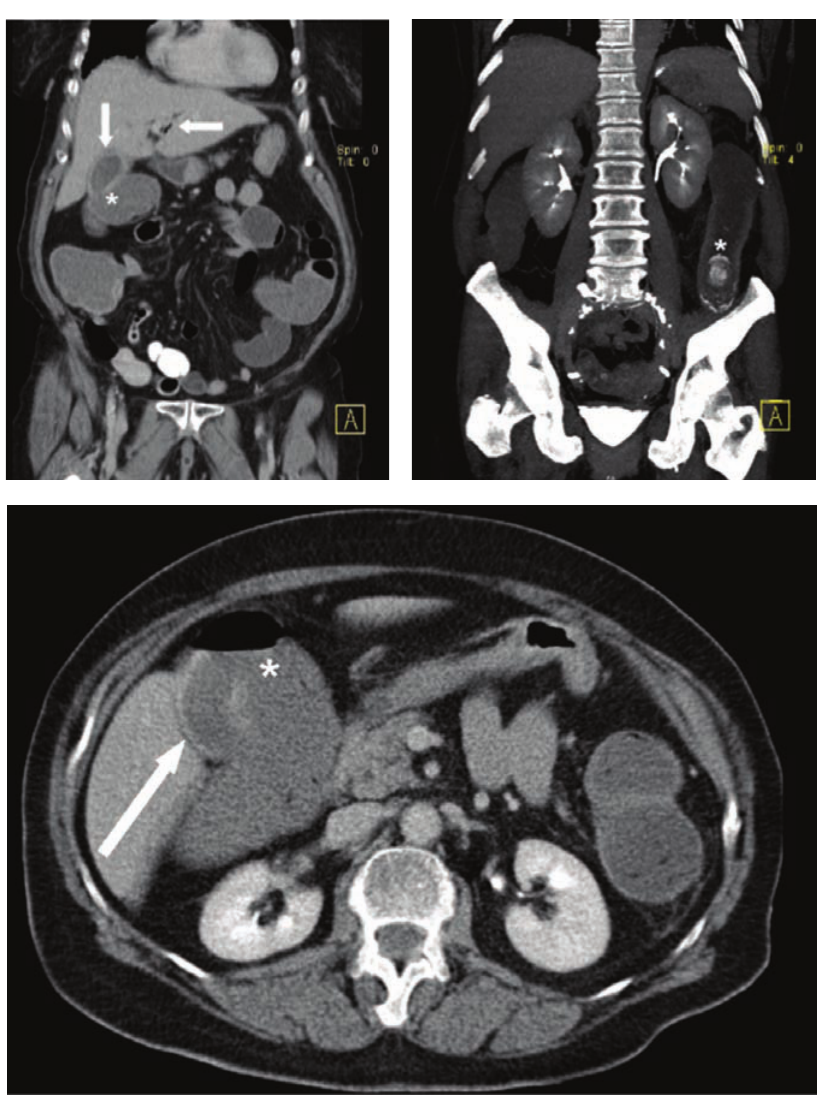
Figure 2: Abdominal CT scan showing a 6-centimetre radiopaque lesion in the descending colon, gall bladder wall thickening (arrow), a cholecystocolonic fistula (asterisk), pneumobilia (arrow), and an ectopic stone in the descending colon